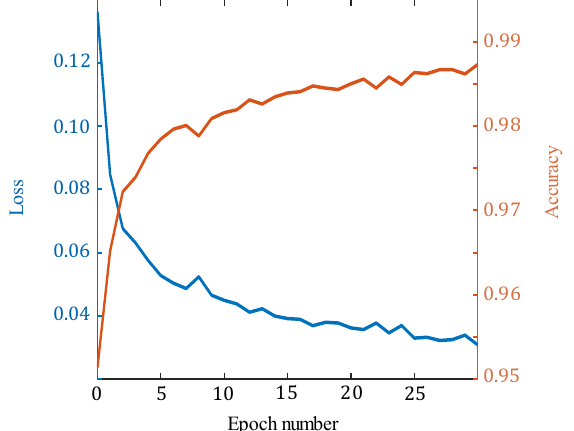
Figure 8. Evolution of the point-wise cross-entropy loss and the overall training accuracy with the epoch number for the training of PointNet.